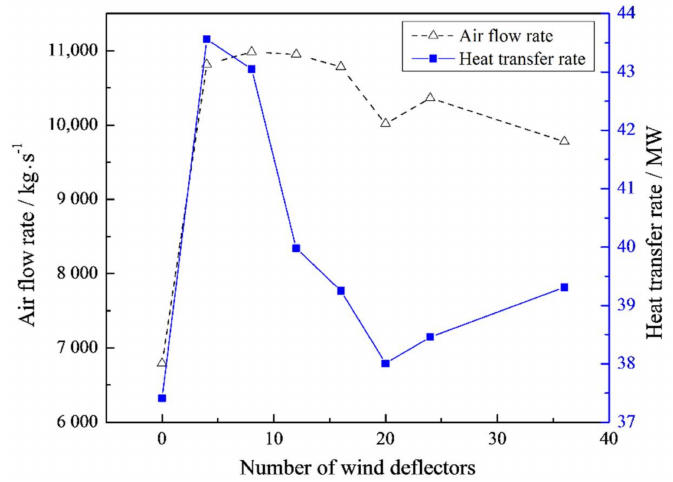
Figure 17. Air flow rate and heat transfer rate versus number of wind deflectors.